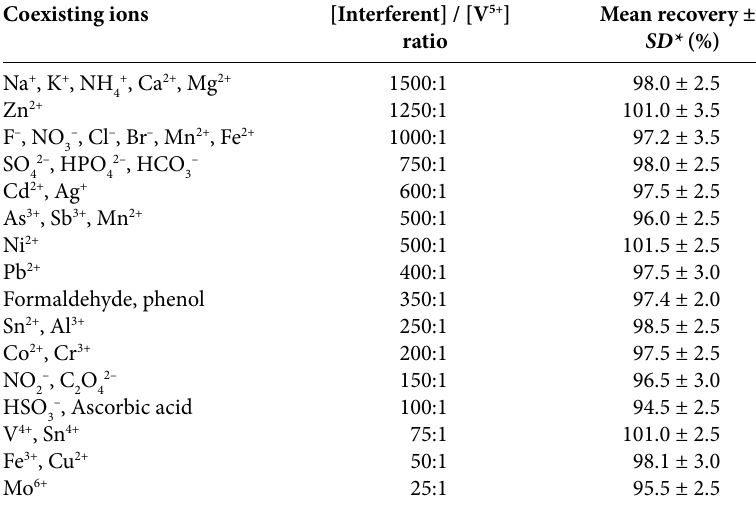
Table 2. The interfering effect of the possible matrix components on three replicate meas- urements of 50 µg L –1 of V(V) (n: 3) Coexisting ions